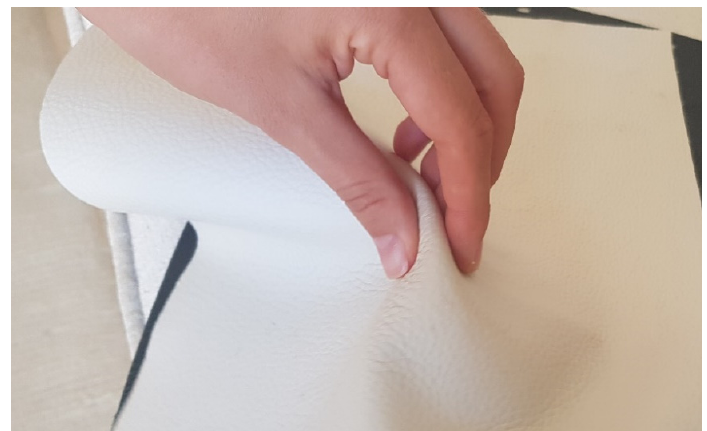
Figure 5. During the proposed VR journey, customers can experience the textures of the materials using real samples, and the ergonomics by sitting on a real sofa with similar specifications to the virtual one.